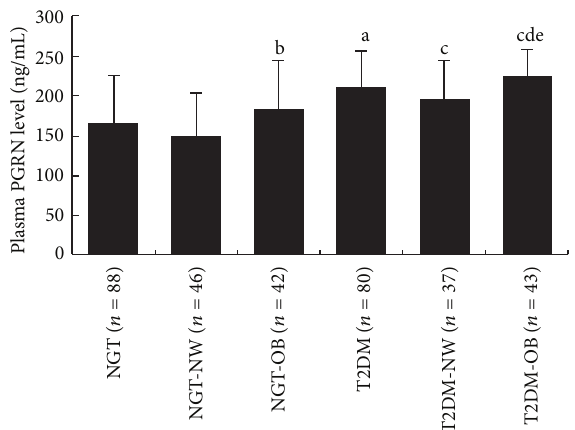
Figure 1: Plasma PGRN levels in different groups. Data are pre- sented as means ± SD. a 𝑃 < 0.01 compared with NGT; b 𝑃 < 0.05 compared with NGT-NW; c 𝑃 < 0.01 compared with NGT-NW; d 𝑃 < 0.01 compared with NGT-OB; e 𝑃 < 0.05 compared with T2DM-NW.